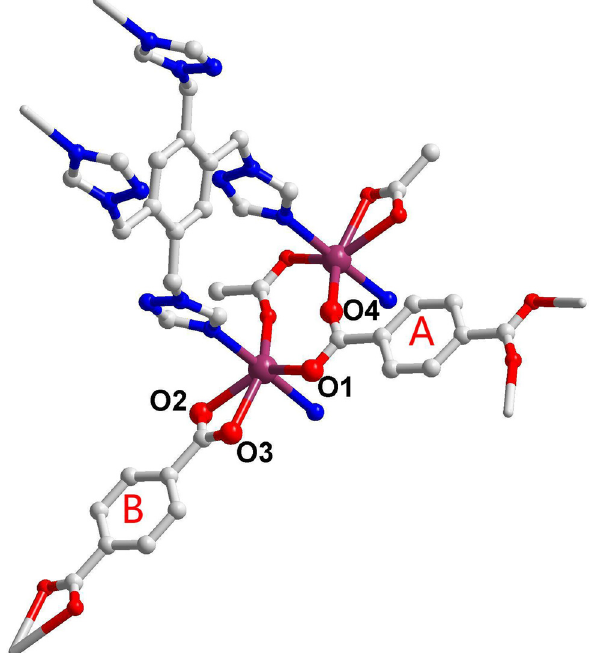
Table  : Data collection and